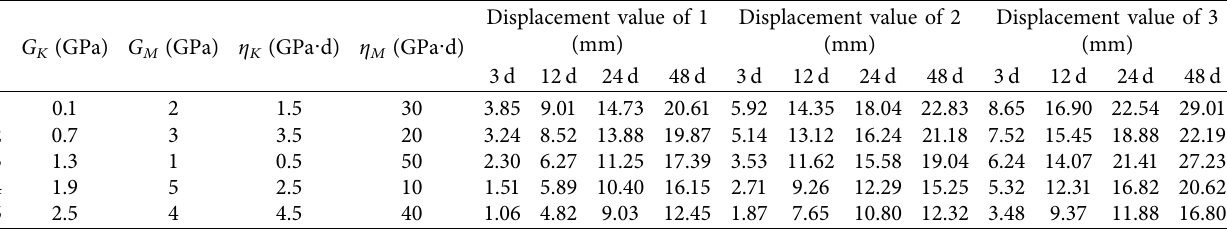
Table 4: The uniform design parameter sample.